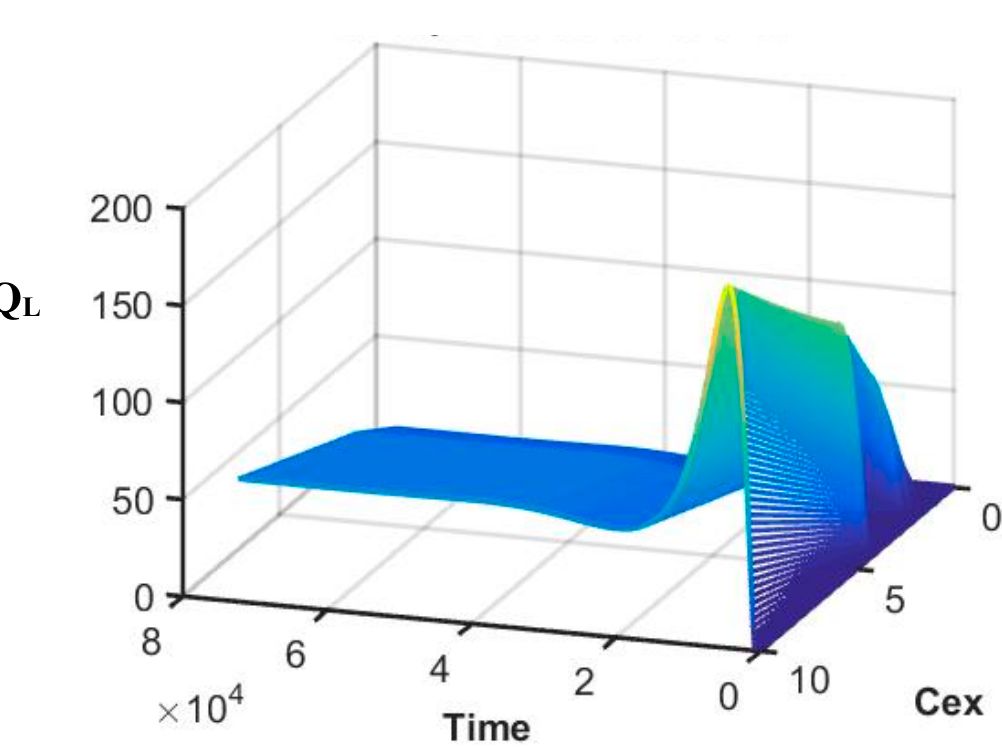
Figure 3. Q L response at various Figure 3: Q L response at various [cCF10]